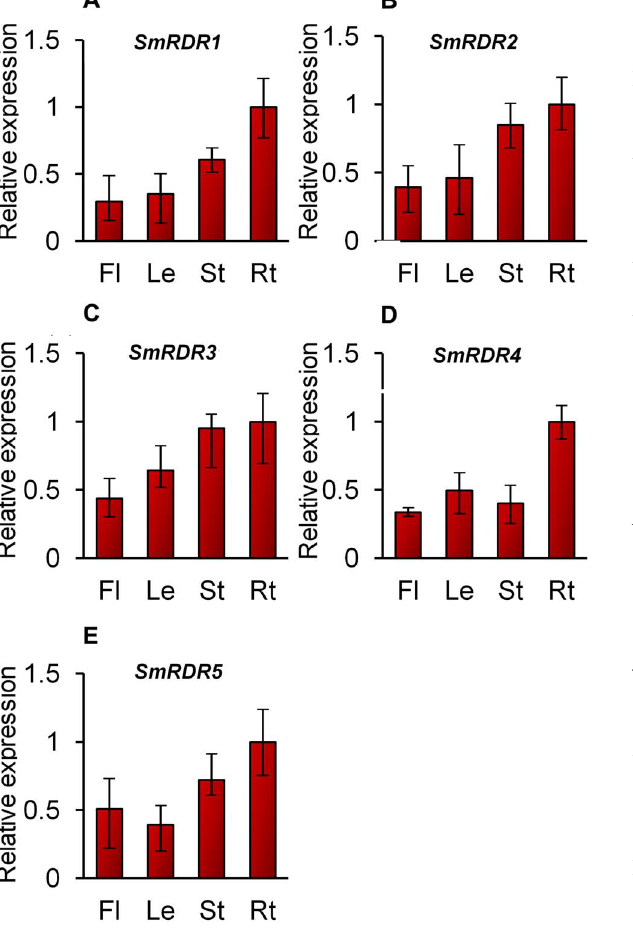
Figure 6. Expression of SmRDRs in flowers (Fl), leaves (Le), stems (St) and roots (Rt) of S.miltiorrhiza . The expression patterns were analyzed using the quantitative RT-PCR method. PCR was carried out in triplicates for each biological sample. Three independent biological replicates were performed. SmUBQ10 was used as a reference. Fold changes of SmRDR expression are shown. The levels in roots were arbitrarily set to 1 and the levels in other tissues were given relative to this. Error bars represent the standard deviations of the mean value of three biological replicates.